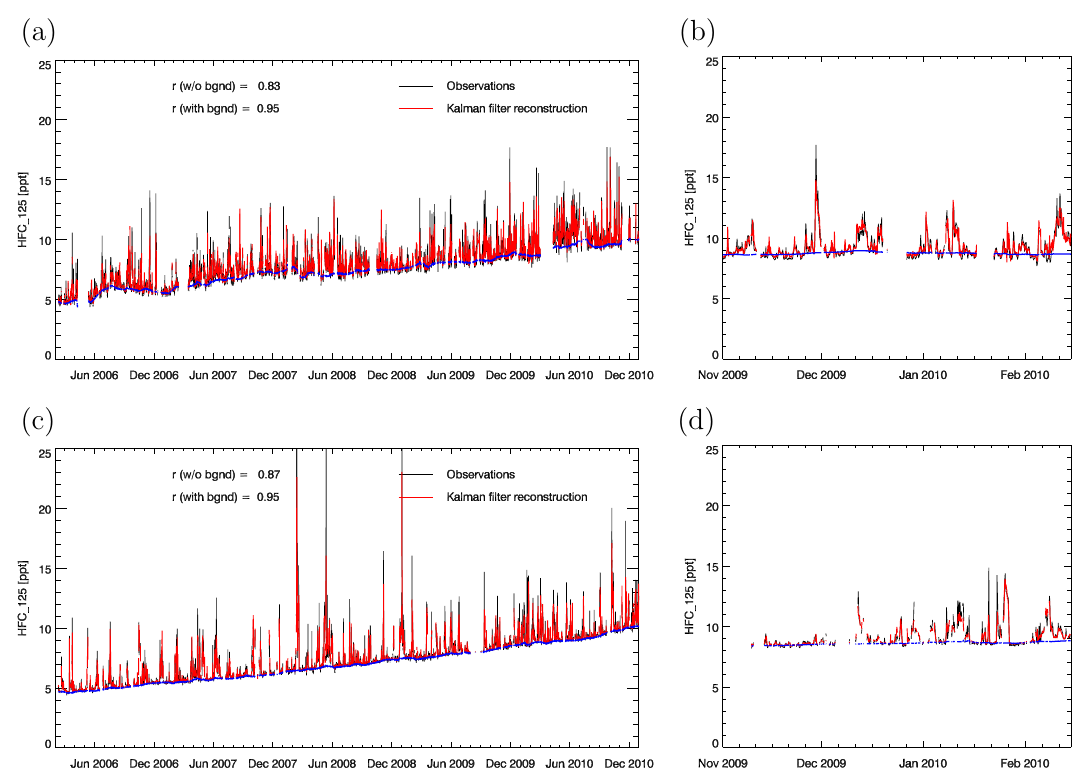
Fig. 9. Comparison of observed (black) and simulated (red) time series at (a) , (b) Jungfraujoch and (c) , (d) Mace Head from 2006 to 2010. Dark blue lines are smooth backgrounds estimated by the Kalman filter. The panels to the right present a zoom on the period 1 November 2009–15 February 2010.